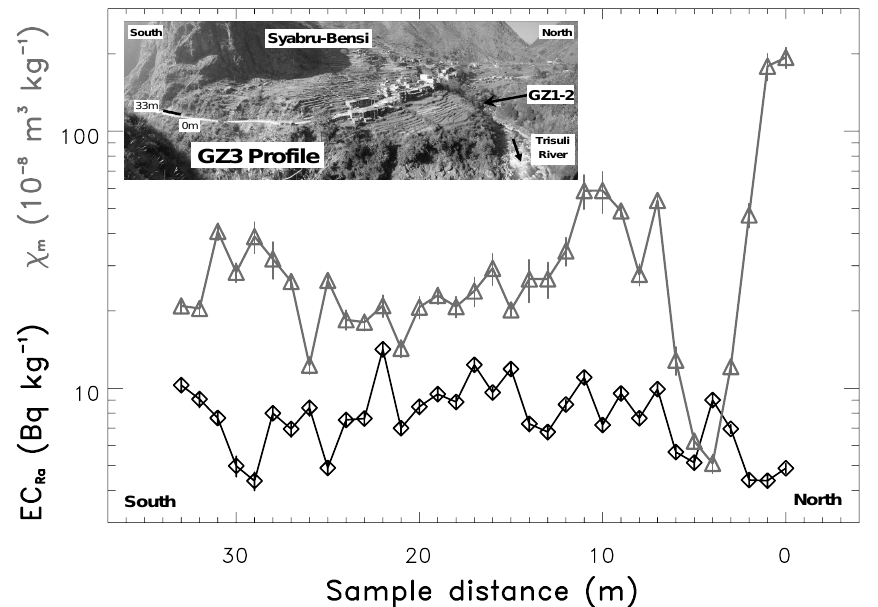
Fig. 2. Transect of χ m and EC Ra along the gas discharge zone GZ3 south of the main Syabru-Bensi geothermal system, Nepal (Girault et al., 2009). A view of the sampling zone is shown in the